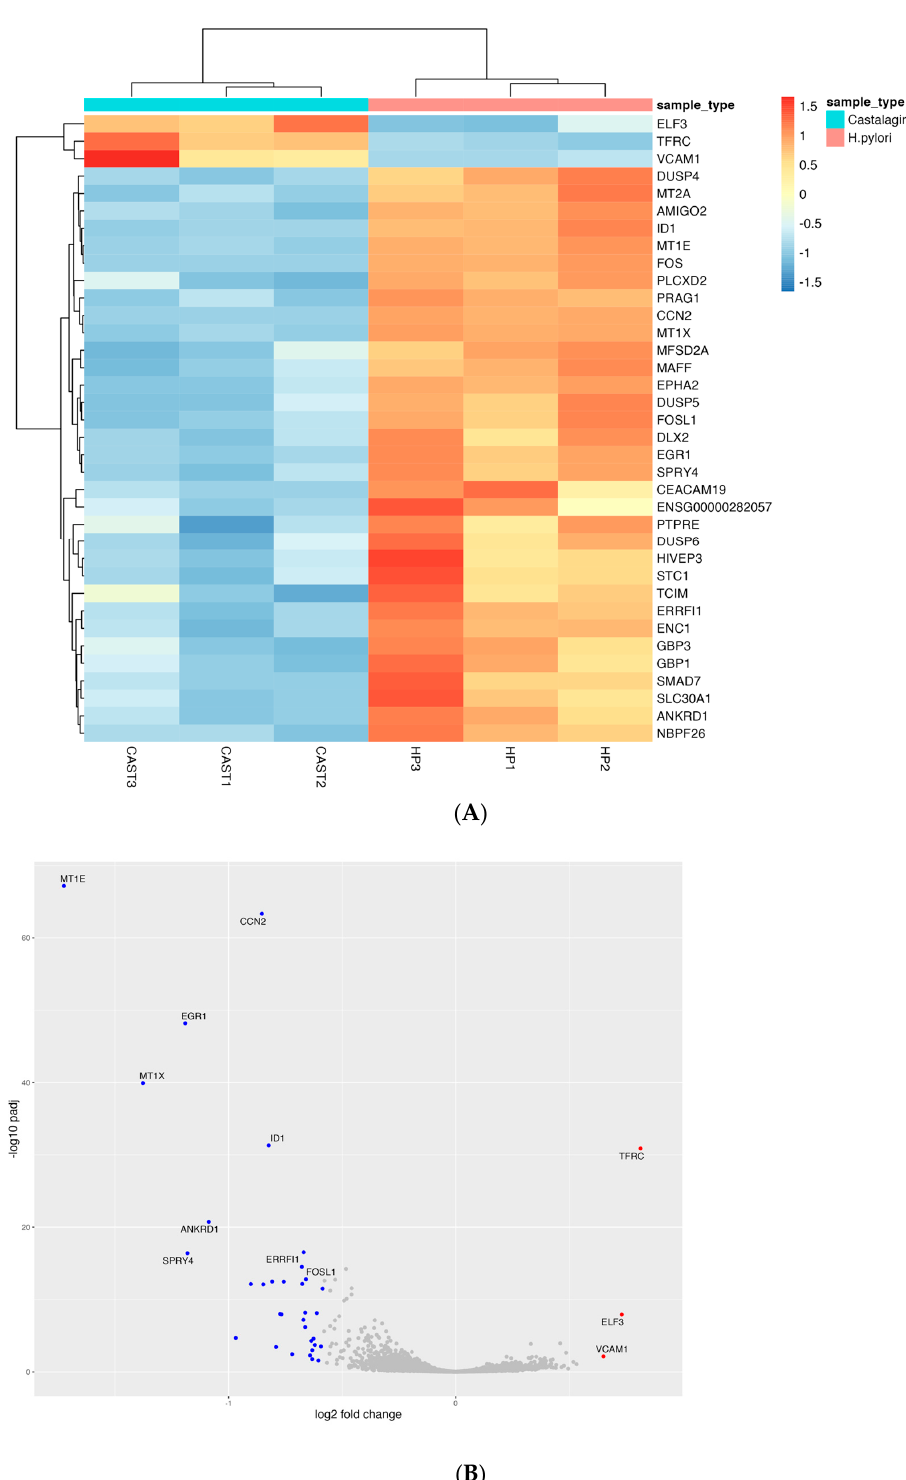
Figure 9. Heatmap showing the trend of the 36 differentially expressed genes between samples treated with H. pylori and samples treated with both H. pylori and castalagin ( A ). Volcano plot representing the downregulated and upregulated genes with blue and red dots, respectively ( B ). Of note, considering the same subgroup of genes, most of them (29 out of 36) were regulated by H. pylori versus control uninfected cells, thus indicating that castalagin was